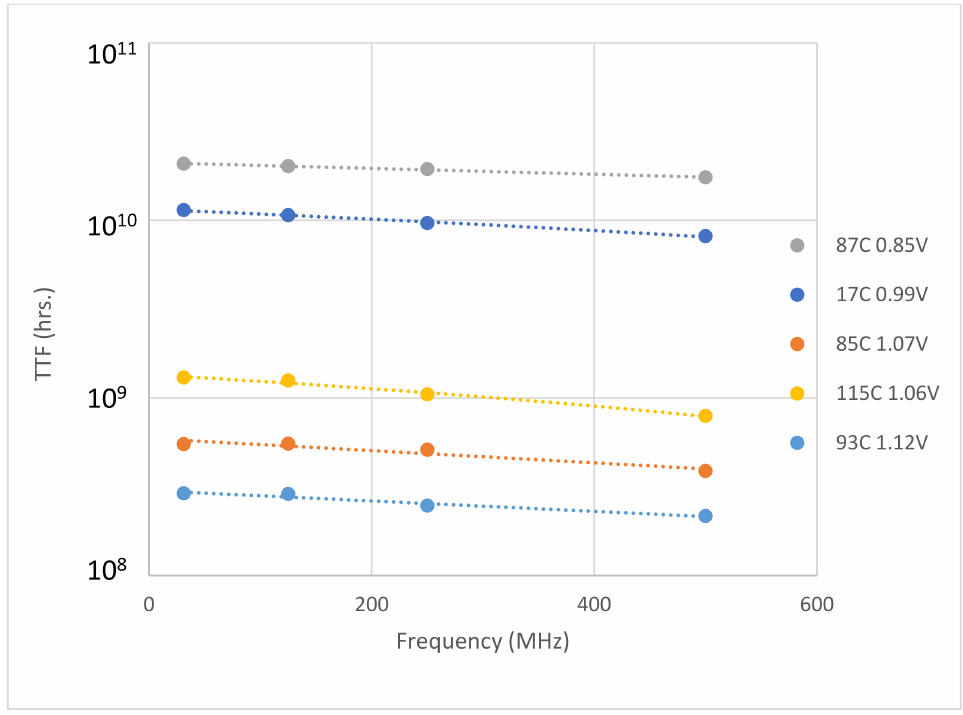
Figure 15. Five TTF to frequency plots averaged over the frequency. The decrease in TTF resembles the results received using